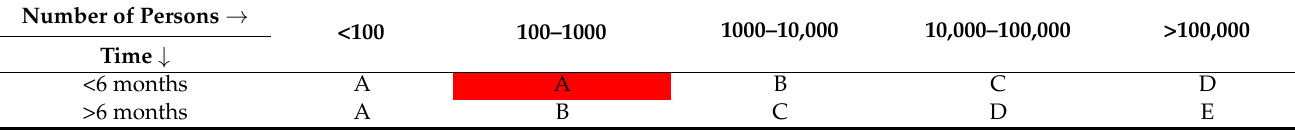
Table A1. Number of evacuated people [24].